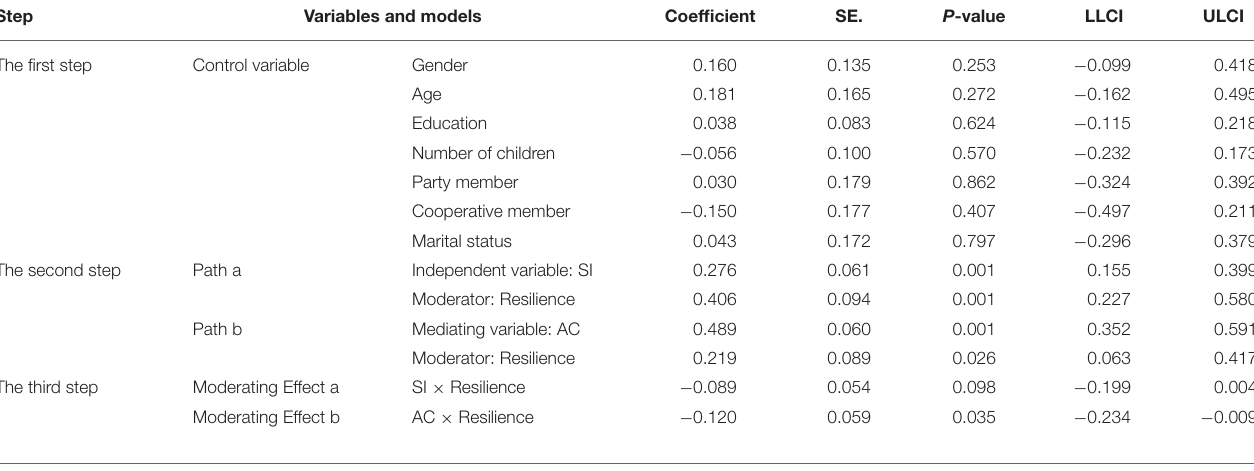
TABLE 7 | Analysis results of the moderating effect of resilience of villagers.